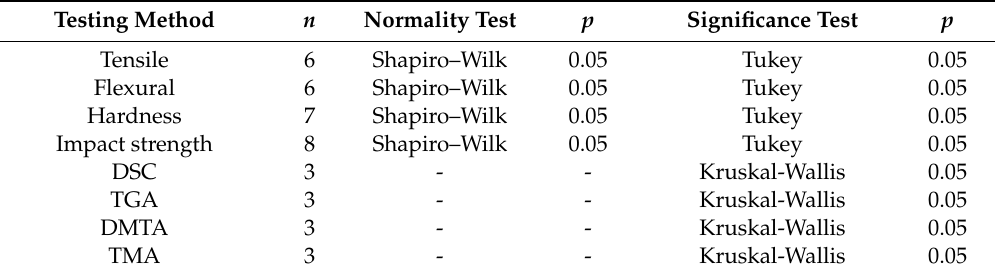
Number of tested samples ( n ) for each injection-molded poly(3-hydroxybutyrate- co -3- hydroxyhexanoate)[P(3HB- co -3HHx)] / hydroxyapatitenanoparticles(nHA)partsandthetypeofstatistical test performed for each testing method with level of significance ( p